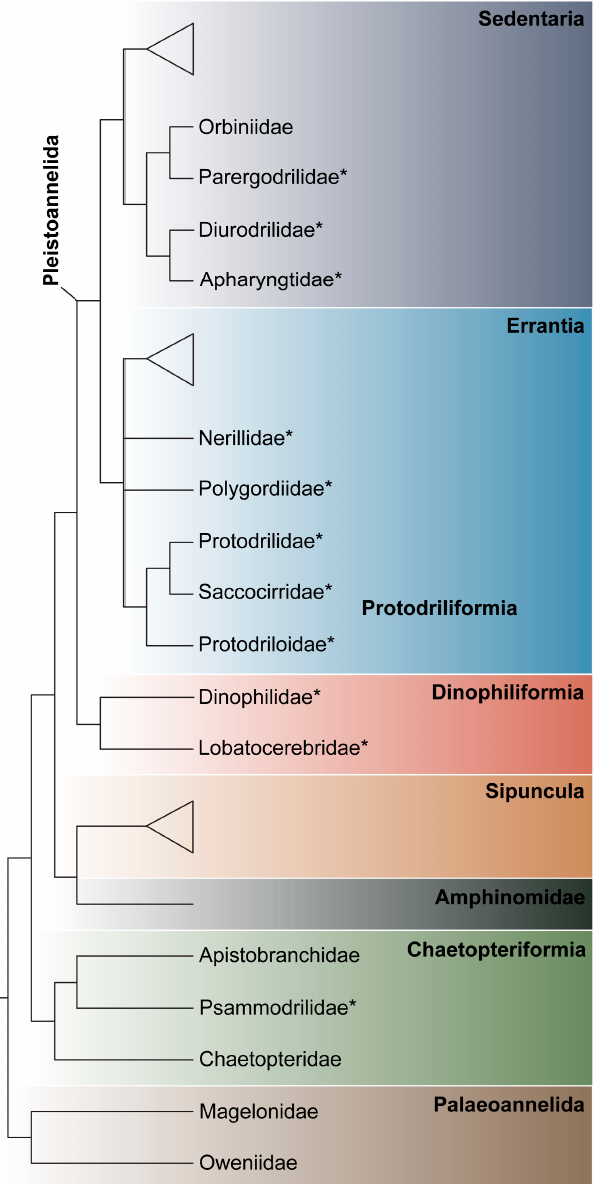
Figure 1. Selected hypotheses on the evolutionary relationship of interstitial annelid families (*), summarizing some of the most recent phylogenomic analyses [3,7–9]. Problems and alternatives to the depicted positions are discussed in the subchapter of each family (e.g., Nerillidae has been suggested to nest both with Errantian and Sedentarian taxa). Branches ending as a triangle indicate a cluster of multiple